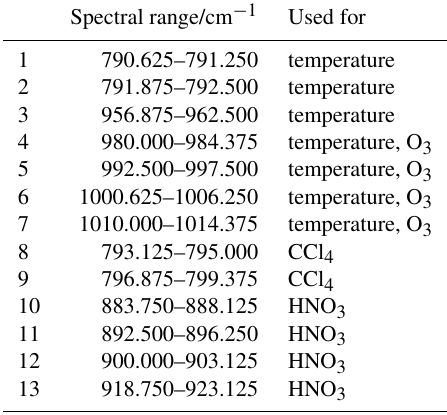
Table 3. Spectral ranges used for the retrievals presented in this paper. The last column indicates the retrieved quantity for each spectral range. For the simulation study (Sect. 3.1 and 3.2), spec- tral ranges 1 to 7 are used. For the real measurement retrievals (Sect. 3.3), spectral ranges 8 to 13 are